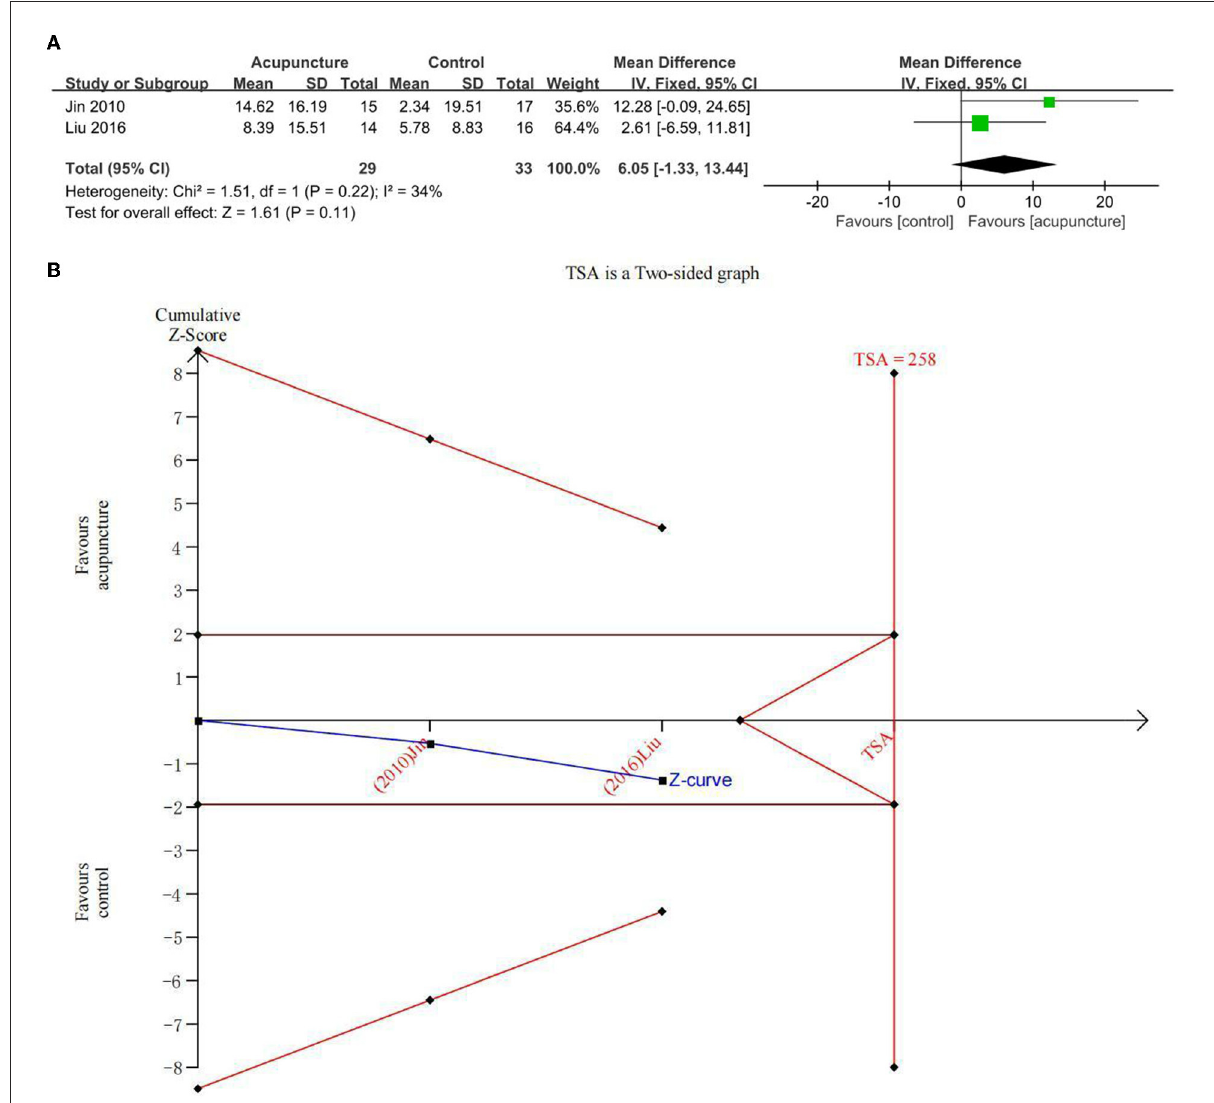
FIGURE5 (A) Forest plot of improvement of clinical memory scale (CMS) and (B) trial sequential analysis of improvement of